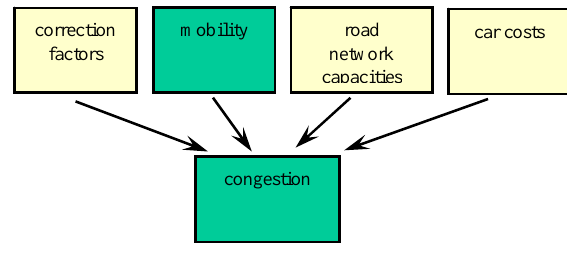
Figure 5.Ccongestion submodel